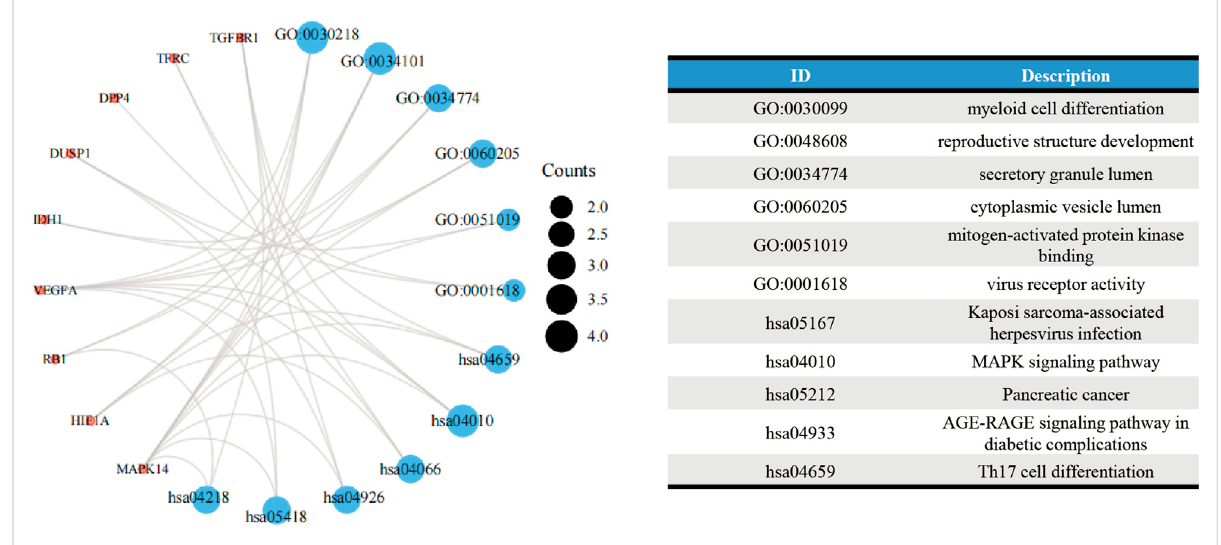
FIGURE 5 Functional-enrichment analyses of Cluster 1